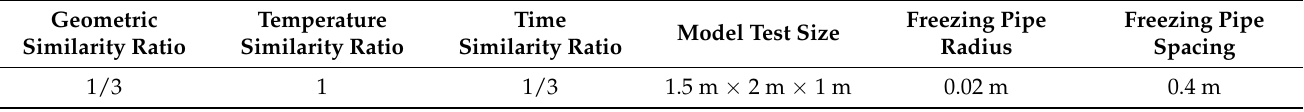
Table 3. Dimensions of the model